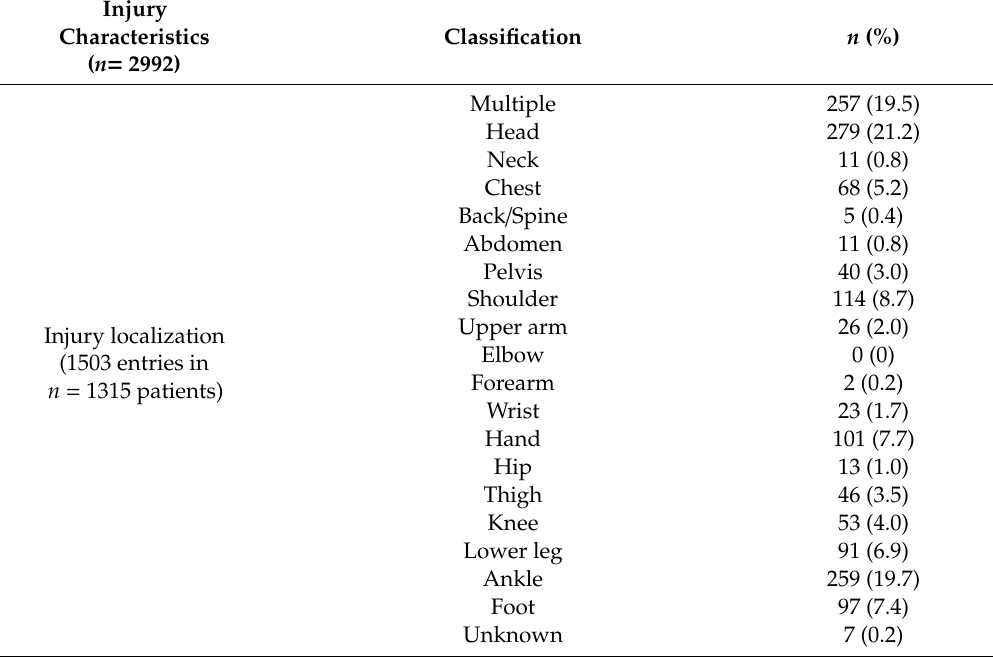
Table 3. Odds ratios adjusted for age and the performed climbing discipline, calculated by logistic regression, with regard to a severe or fatal injury.